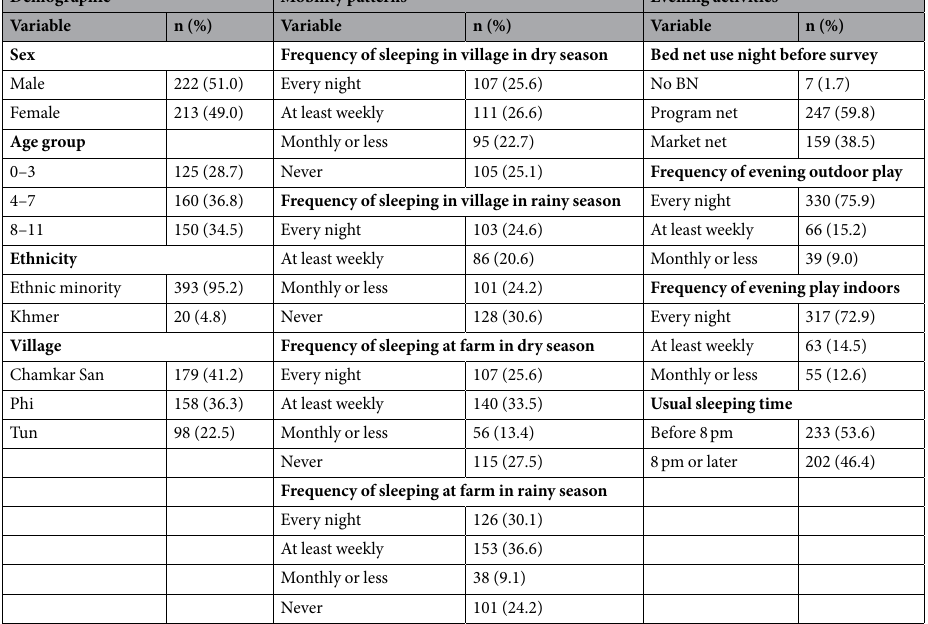
Table 4. Individual-level characteristics of 435 children included in the cross-sectional survey.